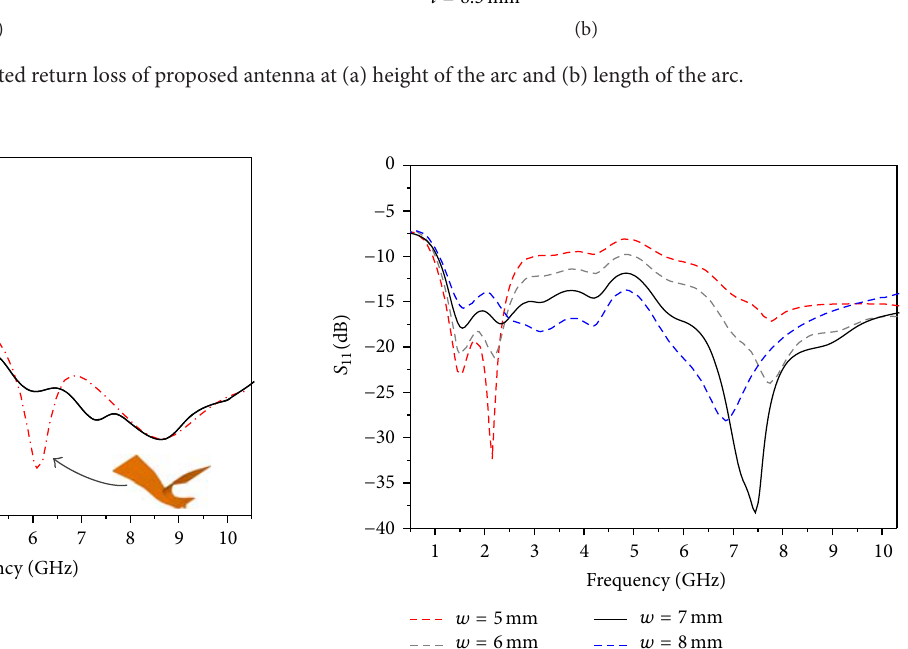
Figure 5: Simulated return loss of proposed antenna at width of